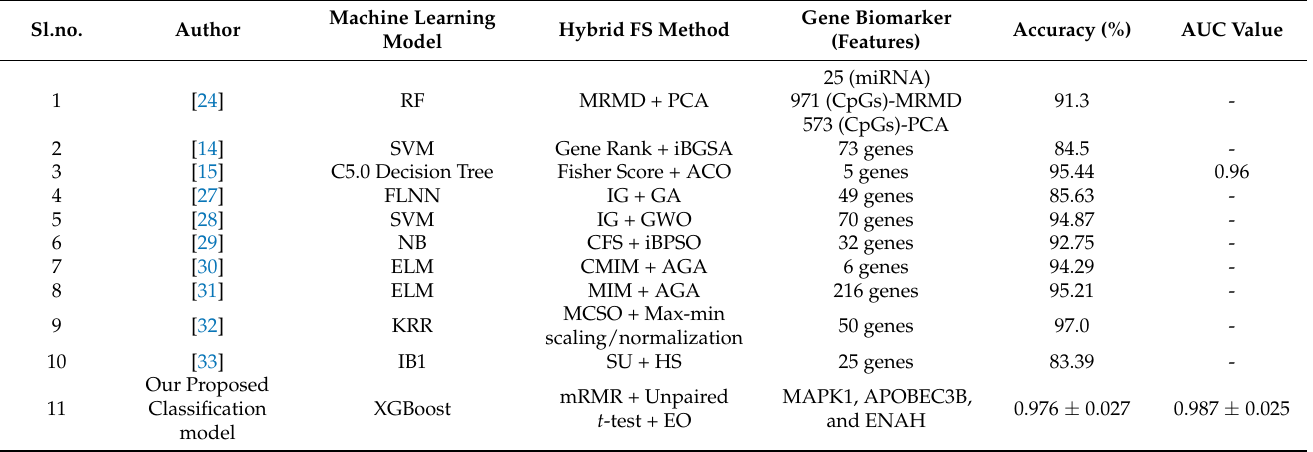
Table 9. Comparative accuracy and AUC value evaluation between models built using features (gene biomarkers) obtained using our proposed hybrid FS